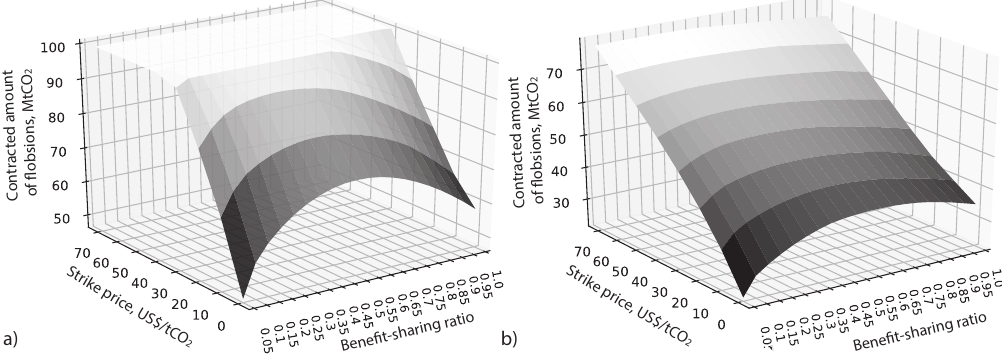
Figure 9. Contracted amounts of flobsions with respect to benefit-sharing ratio, δ ∈ [ 0.05,1 ] and strike price, p min ∈ [ 0,70 ] . We consider risk-averse case A3 with CO 2 distribution (19) and opportunity cost in Equation (20), where: ( a ) K = 0.5, ( b ) K =